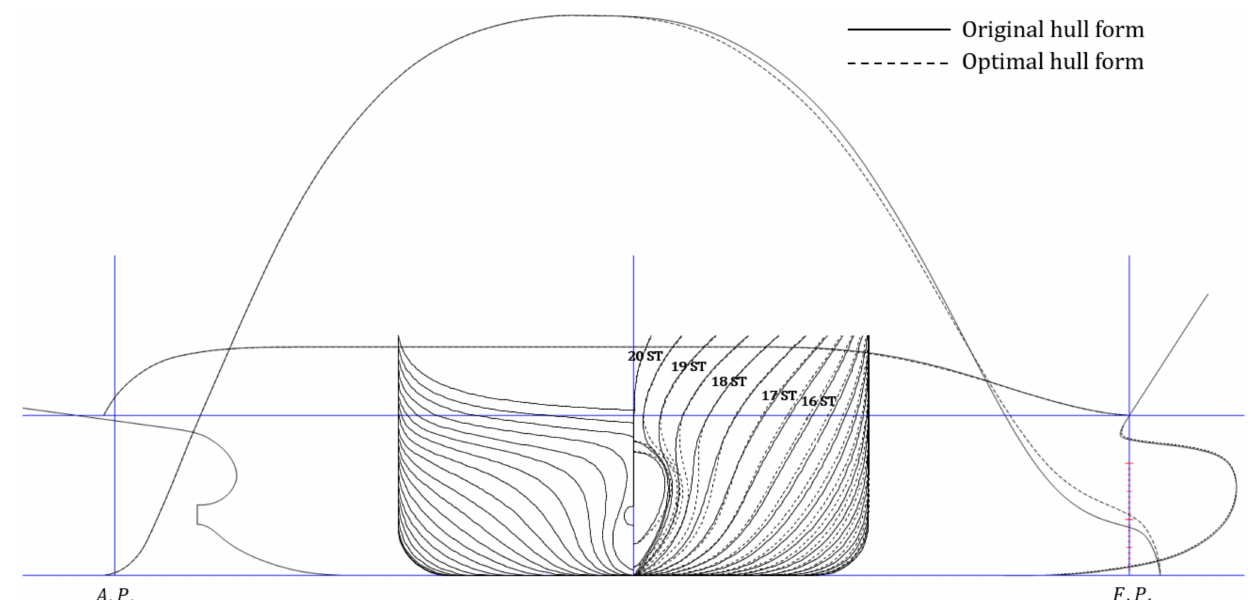
Figure 9. Comparison of original and optimal hull forms.